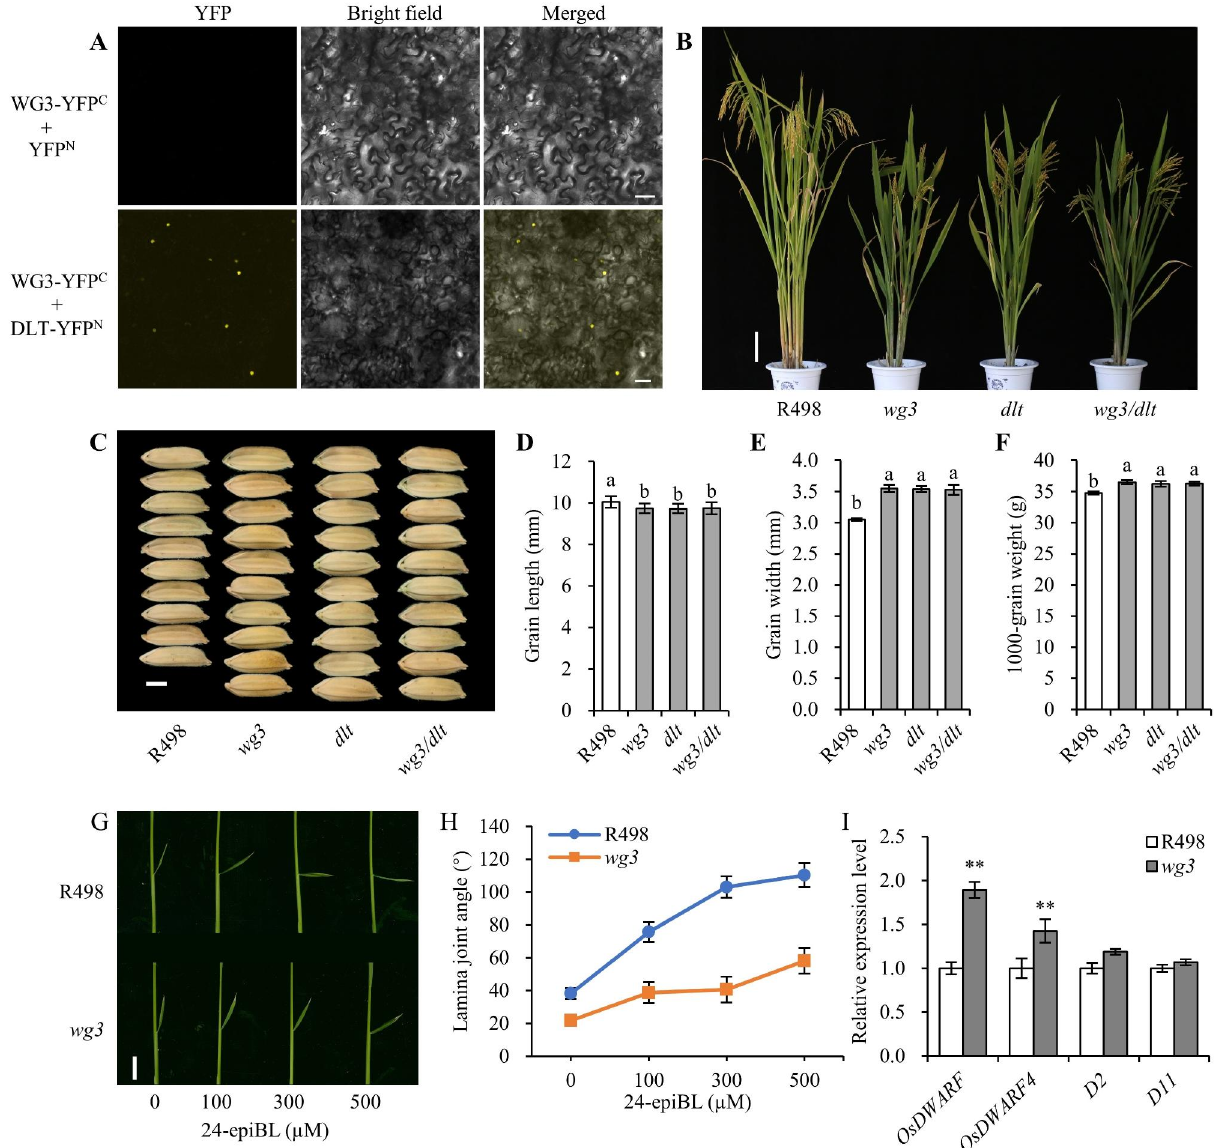
Fig. 2 WG3 interacts with DLT to regulate grain size and BR signaling in rice. (A) BiFC analysis of WG3 and DLT interaction in the epidermal cells of Nico- tiana benthamiana leaves. Scale bar, 50 μm. (B) Plant architecture of R498, wg3 , dlt , and wg3 / dlt at the mature stage. Scale bar, 10 cm. (C) Comparison of grain width between R498, wg3 , dlt , and wg3 / dlt . Scale bar, 3 mm. (D-F) Statistical analysis of grain length (D), grain width (E), and 1000-grain weight (F) between R498, wg3 , dlt , and wg3 / dlt . Data are means ± SD ( n = 3 replicates). Significant differences between R498, wg3 , dlt , and wg3 / dlt were determined using Duncan’s multiple comparisons. (G) Lamina inclination of R498 and wg3 plants treated with different concentrations of 24-epiBL. Scale bar, 1 cm. (H) Statistical analysis of lamina joint angle in G. Data are means ± SD ( n = 20 plants). (I) Comparison of expression levels of four BR biosynthesis genes ( OsDWARF , OsDWARF4 , D2 , and D11) in the young panicles of R498 and wg3 . UBQ5 and FhaB were used as internal controls, and the values of R498 were set to 1. Data are means ± SD ( n = 3 replicates). Significant differences between R498 and wg3 (** P < 0.01) were determined using Student’s t